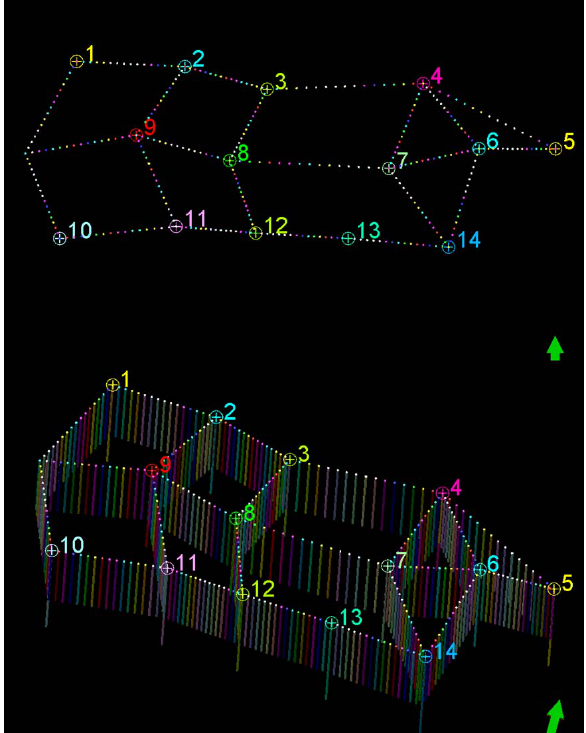
Fig. 6. Map showing positions of the 14 wells and the distance between them (the shortest distance between pairs of wells is 400 m.) It also indicates the 15 pseudo-wells calculated between pairs of wells.